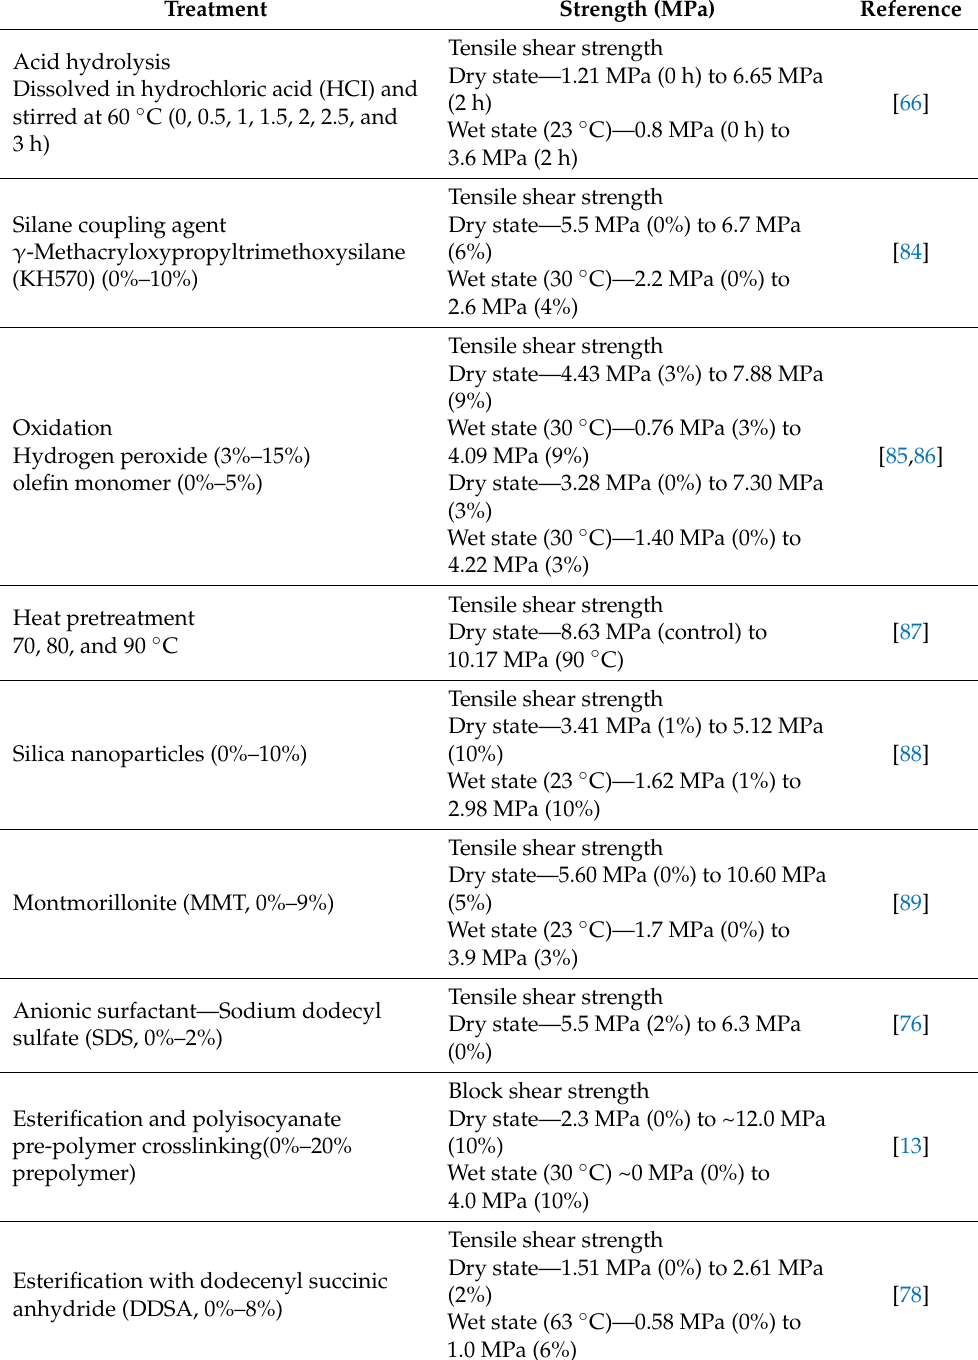
Table 1. Effects of various modification methods on the shear strength of starch-based wood